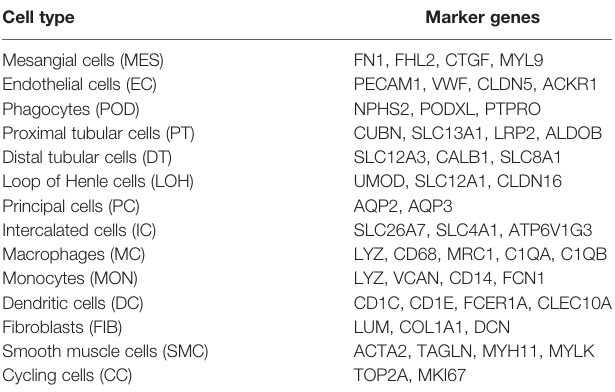
TABLE 1 | Cell-lineage-speci fi c marker genes of different cell